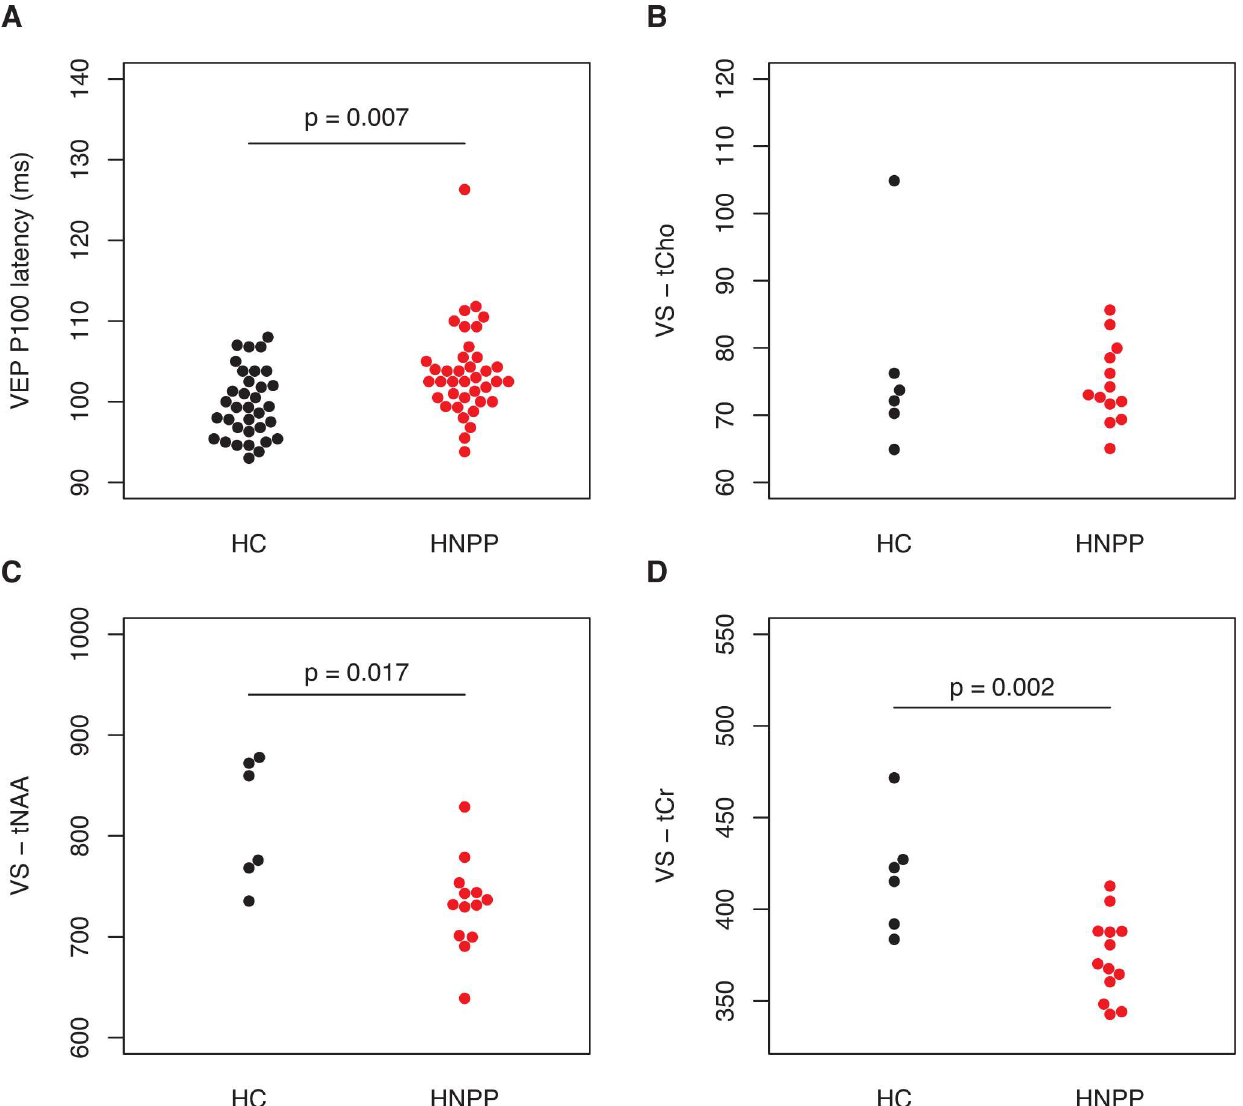
Fig 2. VEP and MRS. Differencesin visual evoked potential (VEP) measurements and magnetic resonancespectroscopy between HNPP patients (in red) and healthy controls (HC, in grey). A) VEP P100 latency, B) visual cortex tCho, C) visual cortex tNAA, D) visual cortex tCr. P values are derived from multiple linear regressionmodels (see